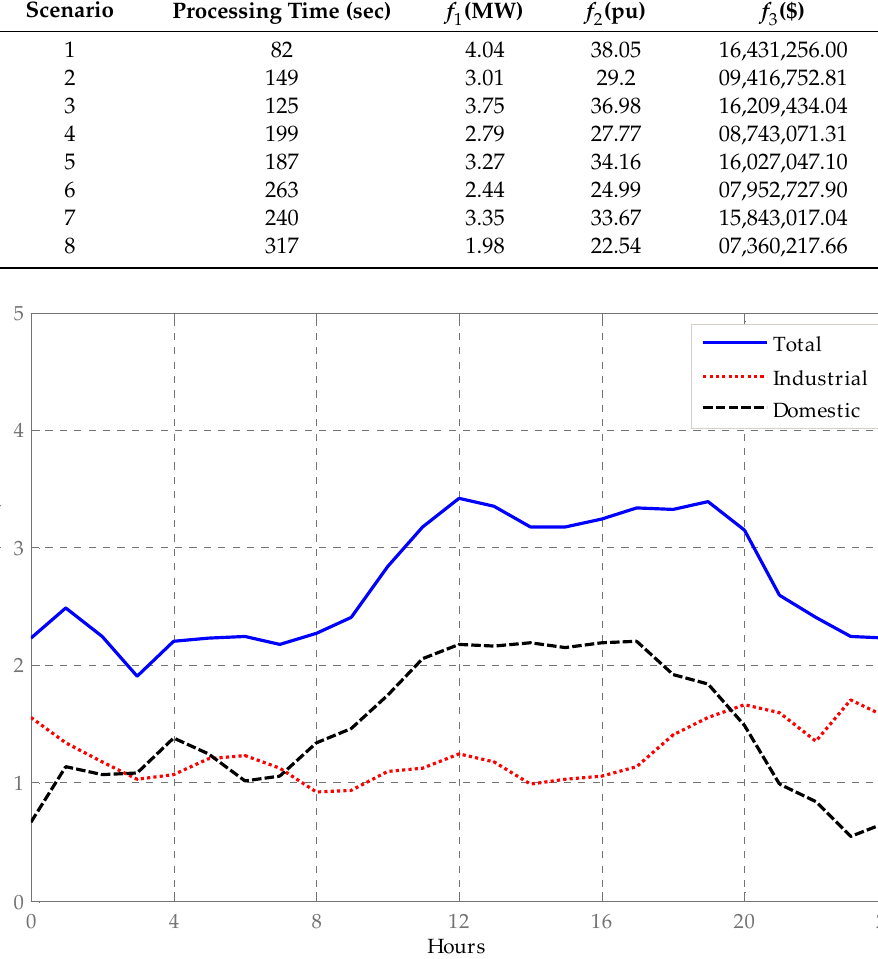
Figure 7. Network 24-hour electrical demand profile (scenario 8). Table 7. Obtained values for target variables through optimization process.